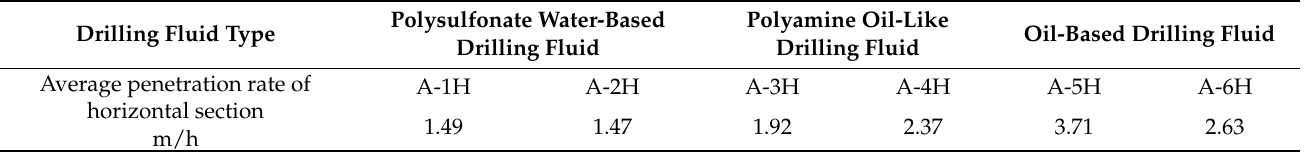
Table 8. Comparative analysis of the penetration rate of oil-based drilling fluid and water-based drilling fluid.